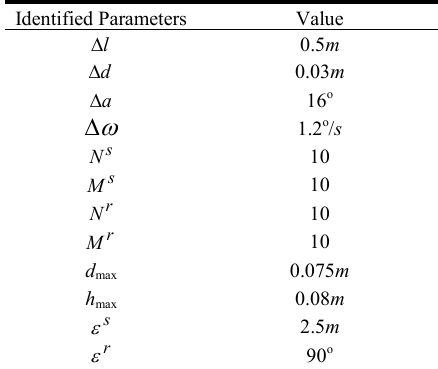
Table 2. Parameters of fuzzy control.